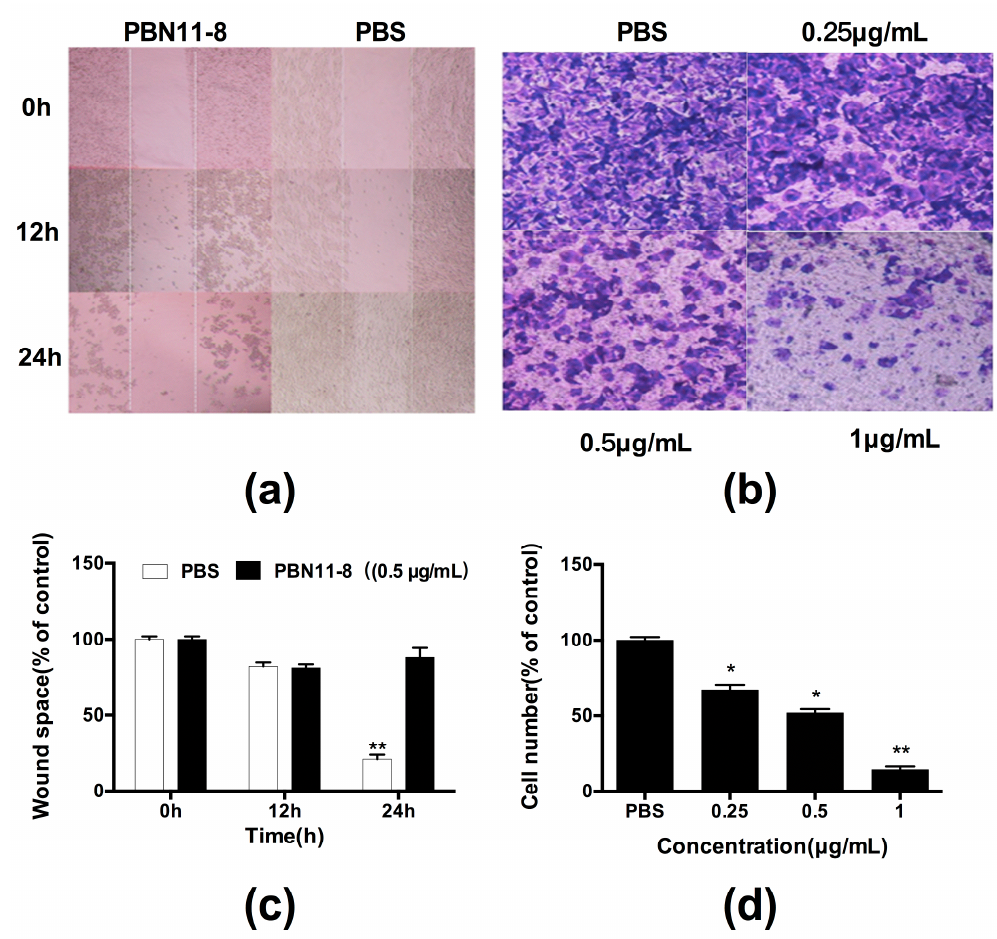
Figure 4. Effect of PBN11-8 on migration and invasion of BEL-7402 cells. ( a ) The scratch test results of the cell migration. ( b ) The detection results of the cell invasion. Quantitative evaluations of BEL-7402 migration induced by PBN11-8 in the Scratch-wound assay ( c ) and Transwell assay ( d ). Data represent the mean ± SD. of three independent experiments. * p < 0.05 vs. control; and ** p < 0.01 vs. control.